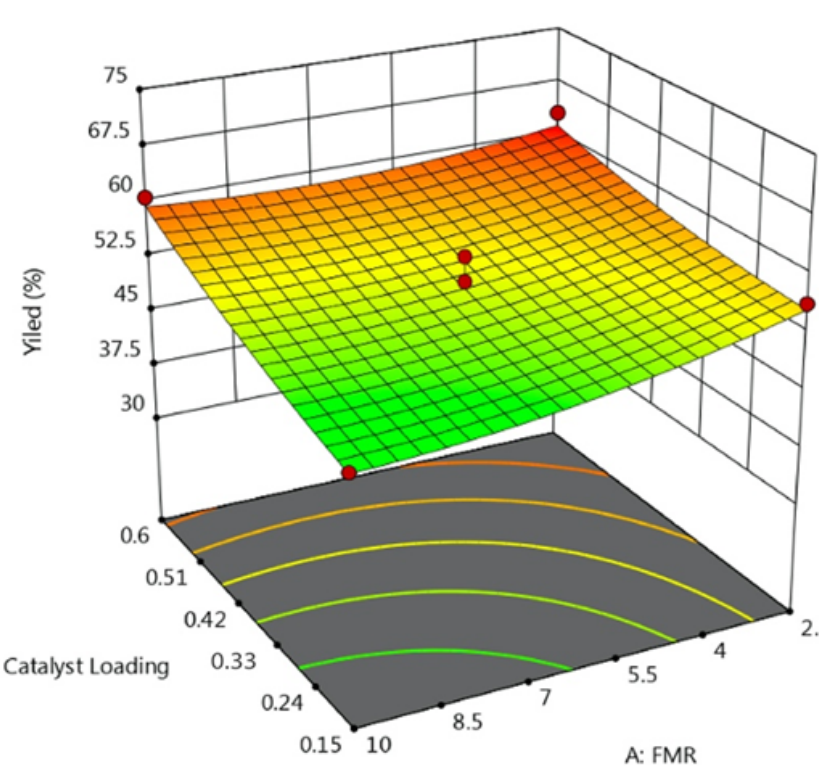
Figure 10. 3-D graph showing the effect of catalyst loading and FMR on the yield of Figure 10. 3 ‐ D graph showing the effect of catalyst loading and FMR on the yield of 1,2 ‐ epoxy ‐ 5 ‐ hexene.